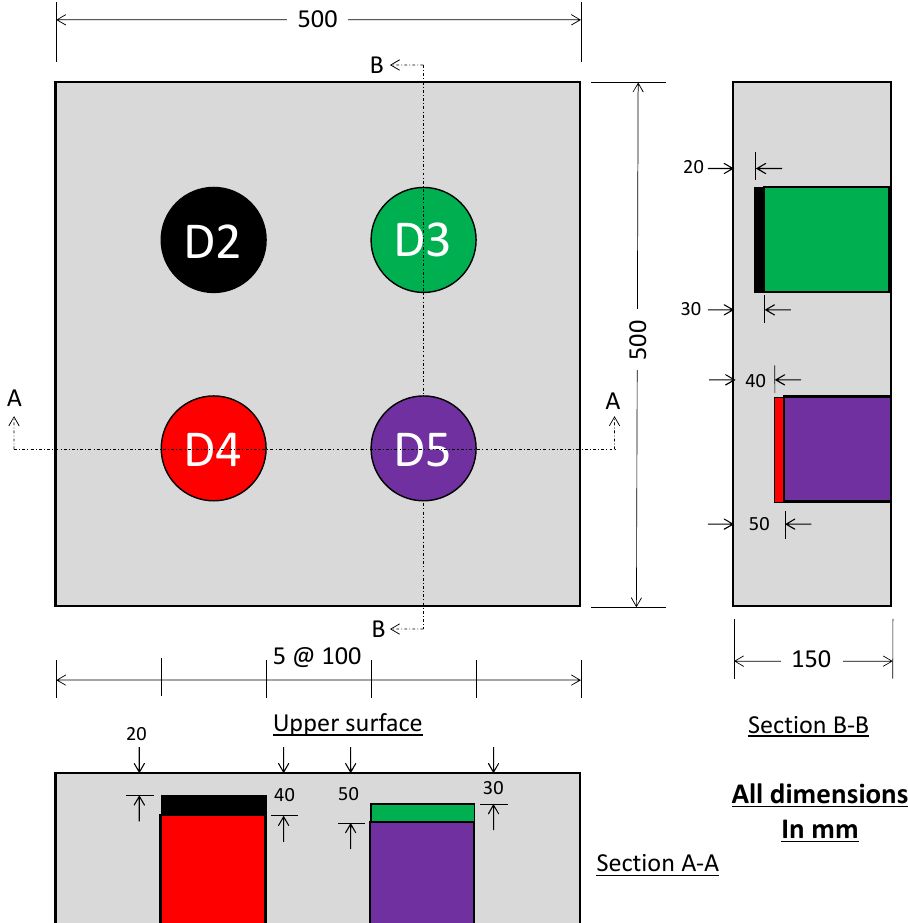
Figure 2. Location, size, and depth of the embedded subsurface defects in the concrete specimen. The schematic drawing is to scale.